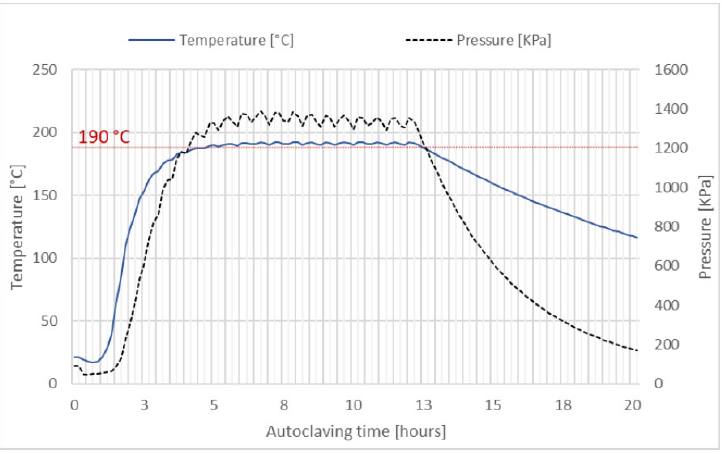
Figure 6. Autoclaving process under industrial conditions [77].